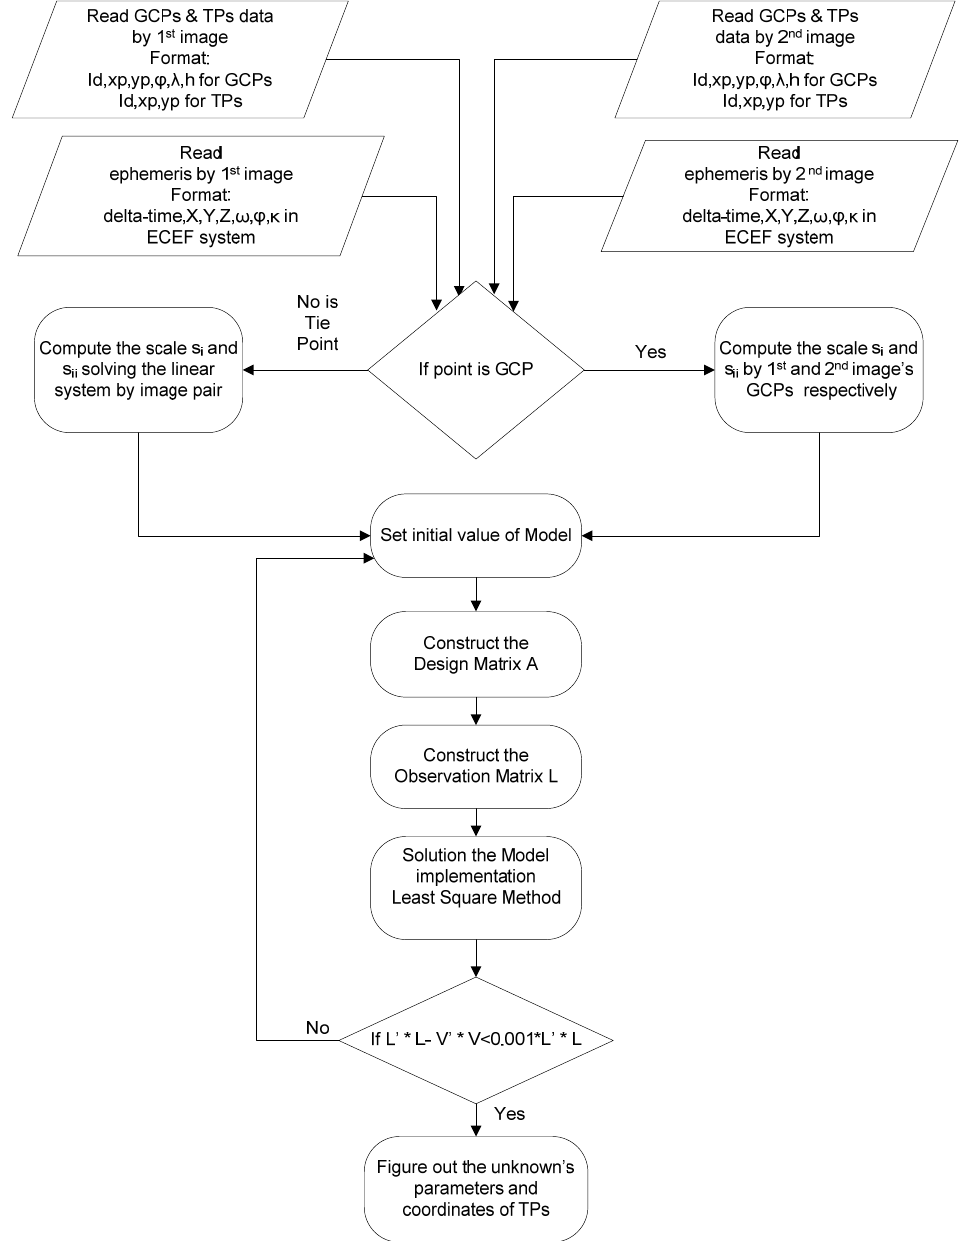
Figure 2. Flow Chart of the implemented